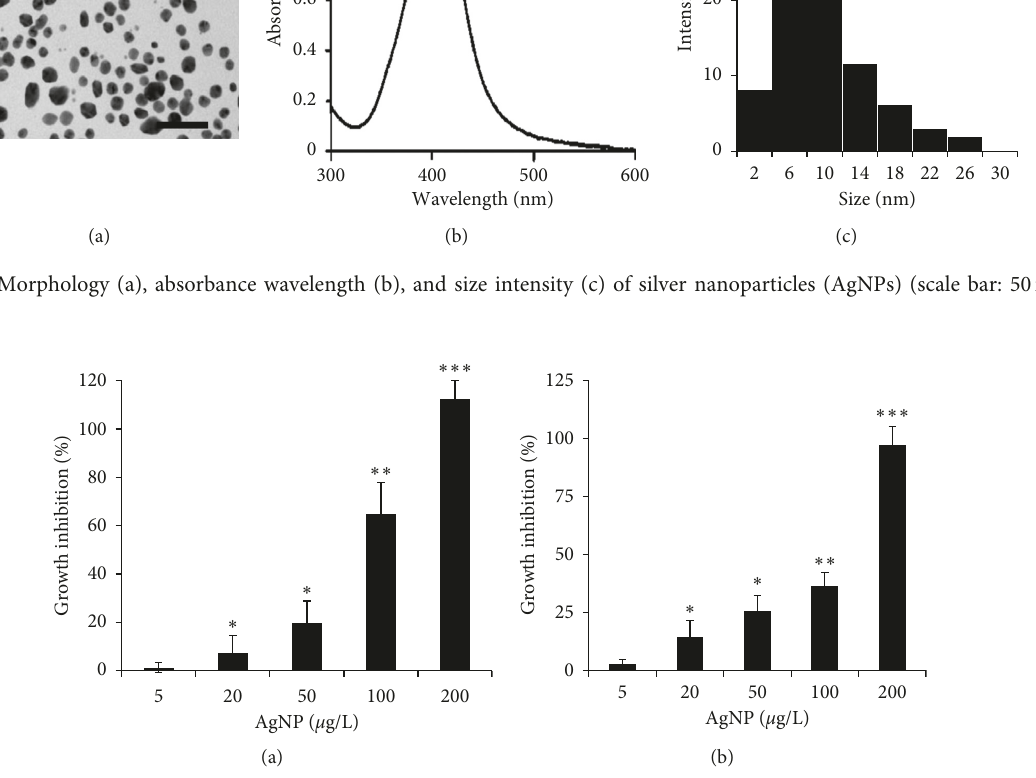
Figure 2: Effect of silver nanoparticles on growth of (a) Scenedesmus sp. and (b) Thalassiosira sp. Asterisks show significant differences compared with the control ( ∗ P < 0 . 05; ∗∗ P < 0 . 01; ∗∗∗ P < 0 . 001).